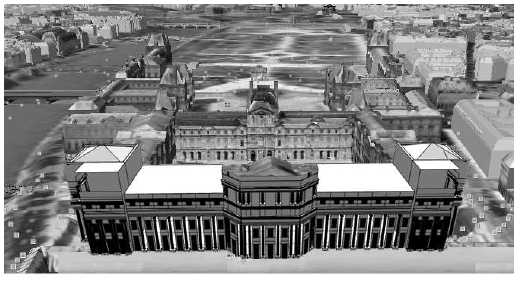
Figure 8: Reconstruction of Le Vau’s 1663 design for the East Wing of the Louvre, in the Context of a Google Earth Aerial